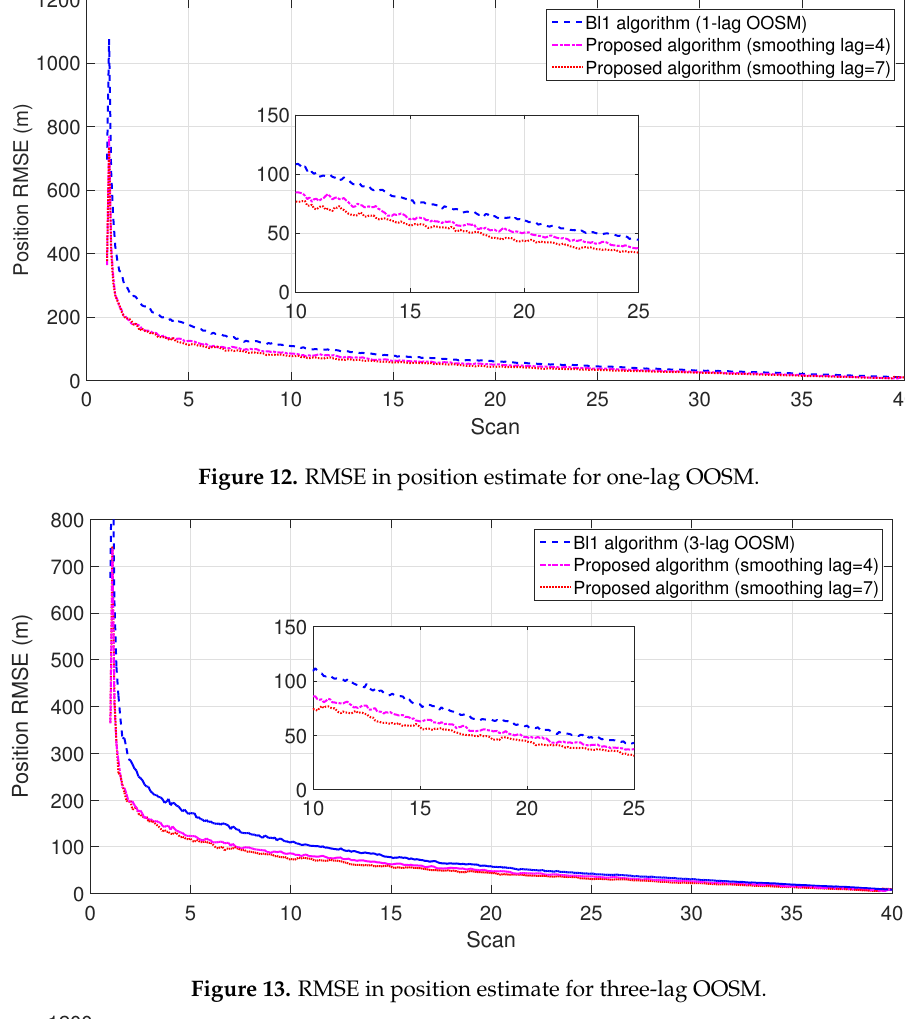
Bl1 algorithm (5-lag OOSM) Proposed algorithm (smoothing lag=4) Proposed algorithm (smoothing lag=7)